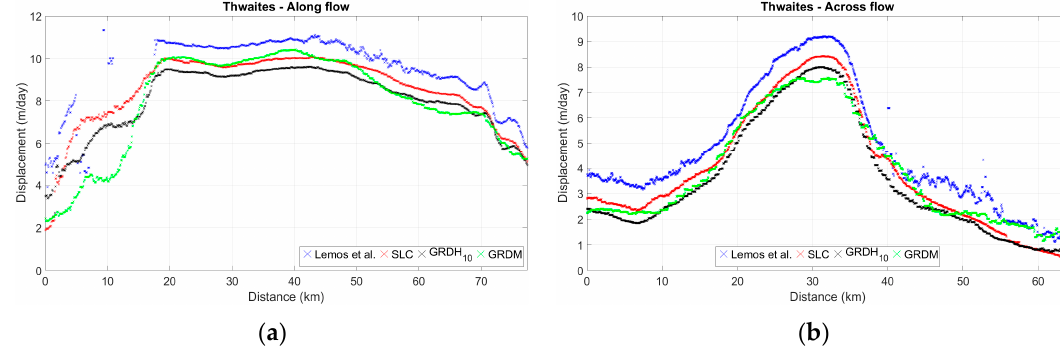
Figure 9. THW, average annual flow speed for reference data (blue curve) and all the analyzed products (IW SLC red curve, IW GRDH black curve, EW GRDM green curve). ( a ) Along flow speed. ( b ) Across flow speed.